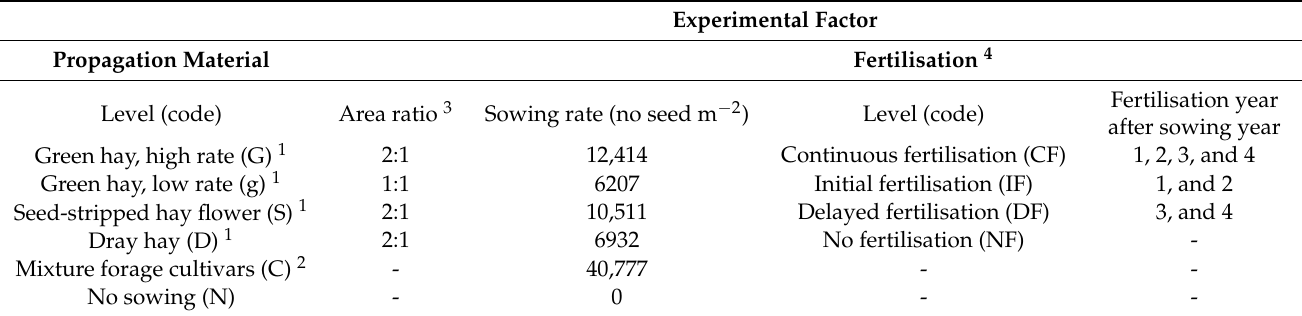
Table 1. Experimental factors and corresponding levels of the ski slope grassland restoration experiment. Experimental